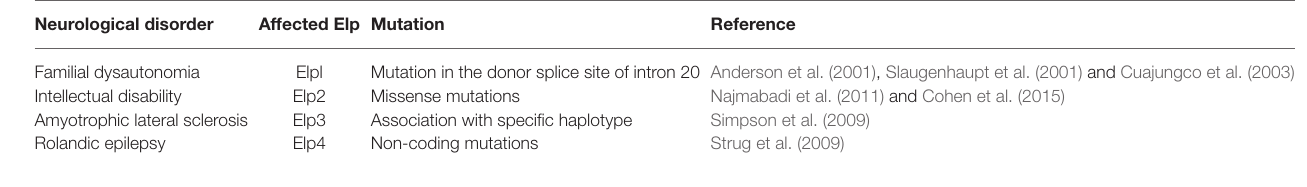
TABLE 1 | Elongator defects in neurological